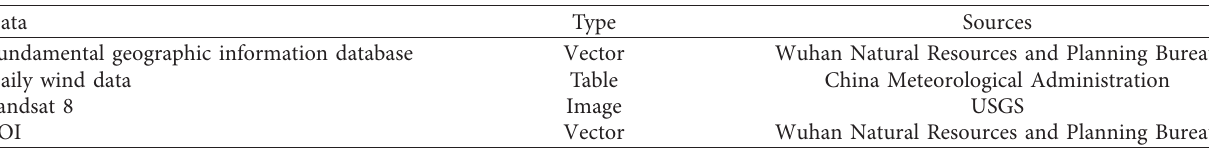
Figure 1: Map of the study area. Table 1: The data